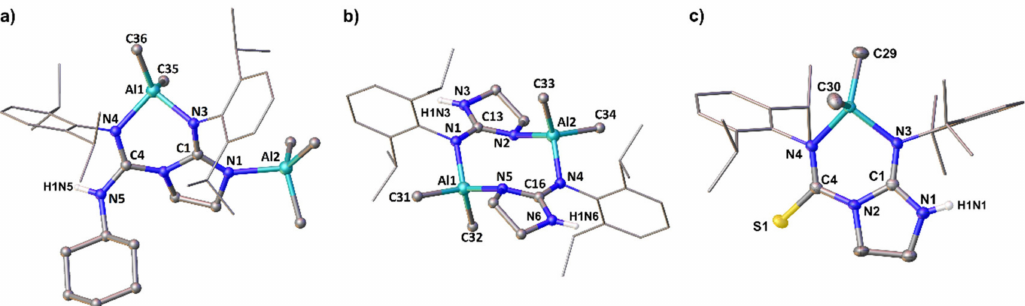
Figure 4. ( a ) Solid-state structure (hydrogen atoms except the NH are omitted for the sake of clarity) with selected bond lengths (Å) and angles (deg) of: ( a ) 4 : Al1–N4 1.9325(17), Al1–N3 1.9255(17), C1–N1 1.318(2), C1–N3 1.330(2),